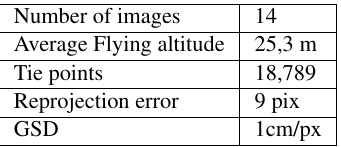
Figure 6. The bottom view of San Francesco church with the positions of the panoramic images used to create the dense point clouds. Table 2. Survey data and processing